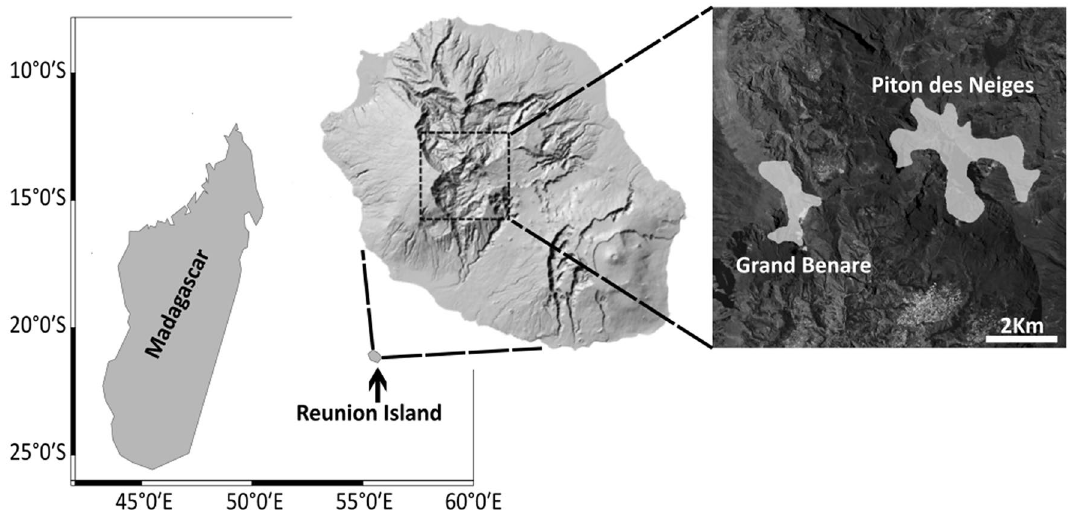
Figure 1. Approximate breeding distribution of Barau’s Petrel ( Pterodroma baraui ; shaded area) on the two central massifs of Réunion Island, Indian Ocean, highlighting the disjunct nature of the breeding colonies on the upper-most mountain slopes. Adapted from Ref. 17 . using satellite imagery from Google Earth Pro and spatially referenced using Ref. 79 . Location of the two Barau’s Petrel breeding colonies are shown in a three-part spatially referenced